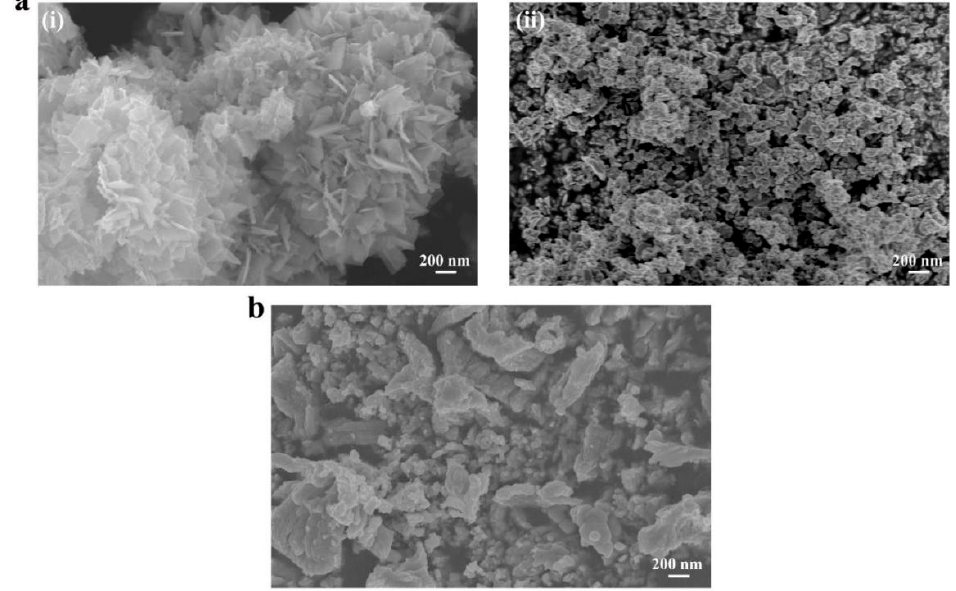
Figure 2. SEM images of the WO 3 powder. ( ai ) nanostructured WO 3 powder before annealing, ( aii ) nanostructured WO 3 powder after annealing. ( b ) ordinary WO 3 powder.